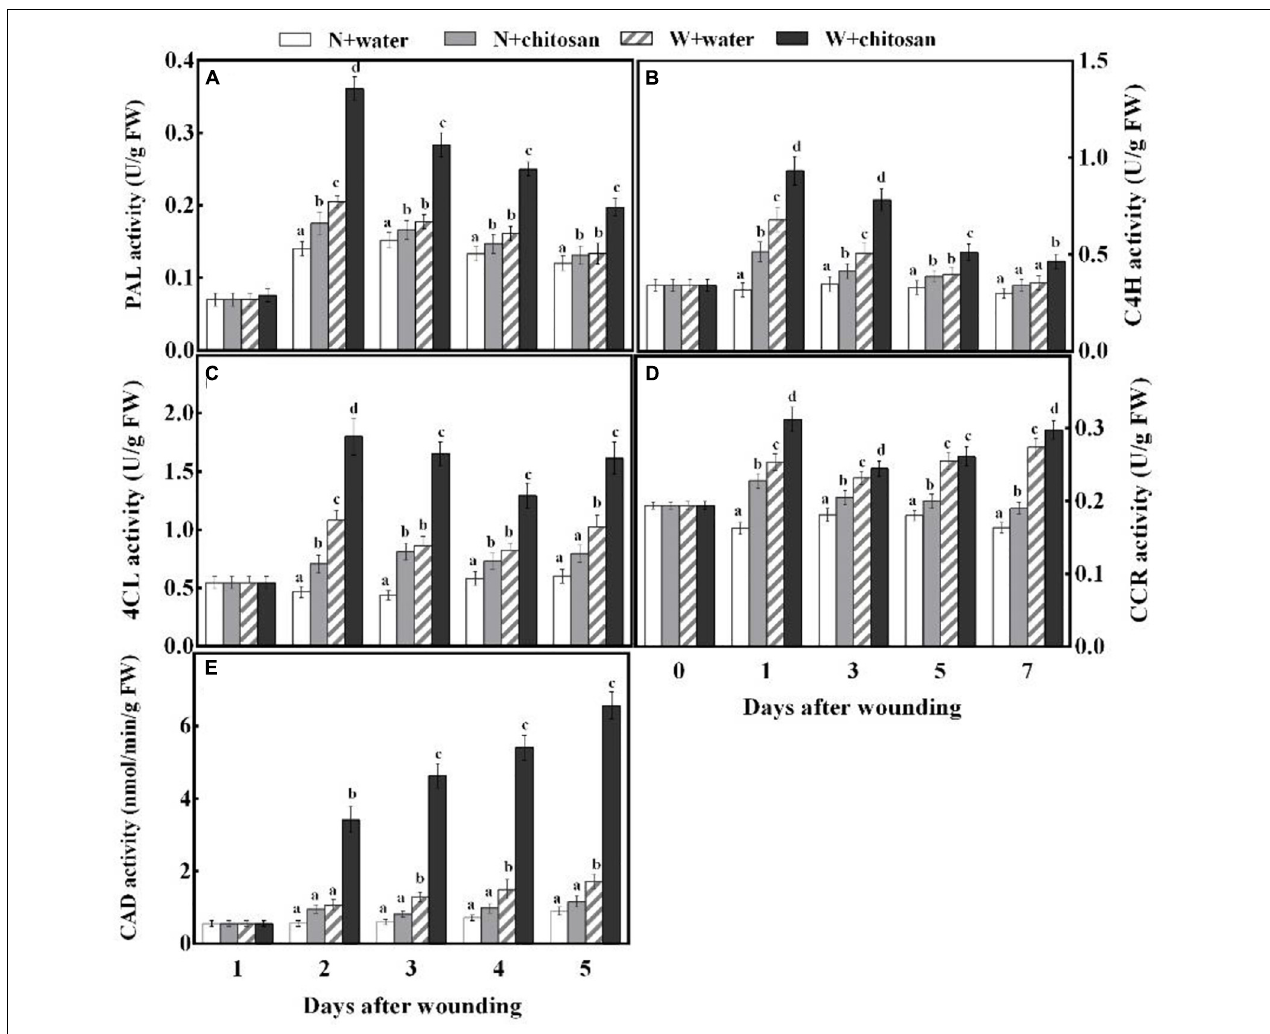
FIGURE 3 | Effect of chitosan treatment on activities of PAL (A) , C4H (B) , 4CL (C) , CCR (D) , and CAD (E) . Non-wounded and treated with sterile water (N + water), non-wounded and treated with chitosan (N + chitosan), wounded and treated with sterile water (W + water), and wounded and treated with chitosan (W + chitosan). Vertical bars indicate standard error of means. Alphabets indicate significant differences ( p <